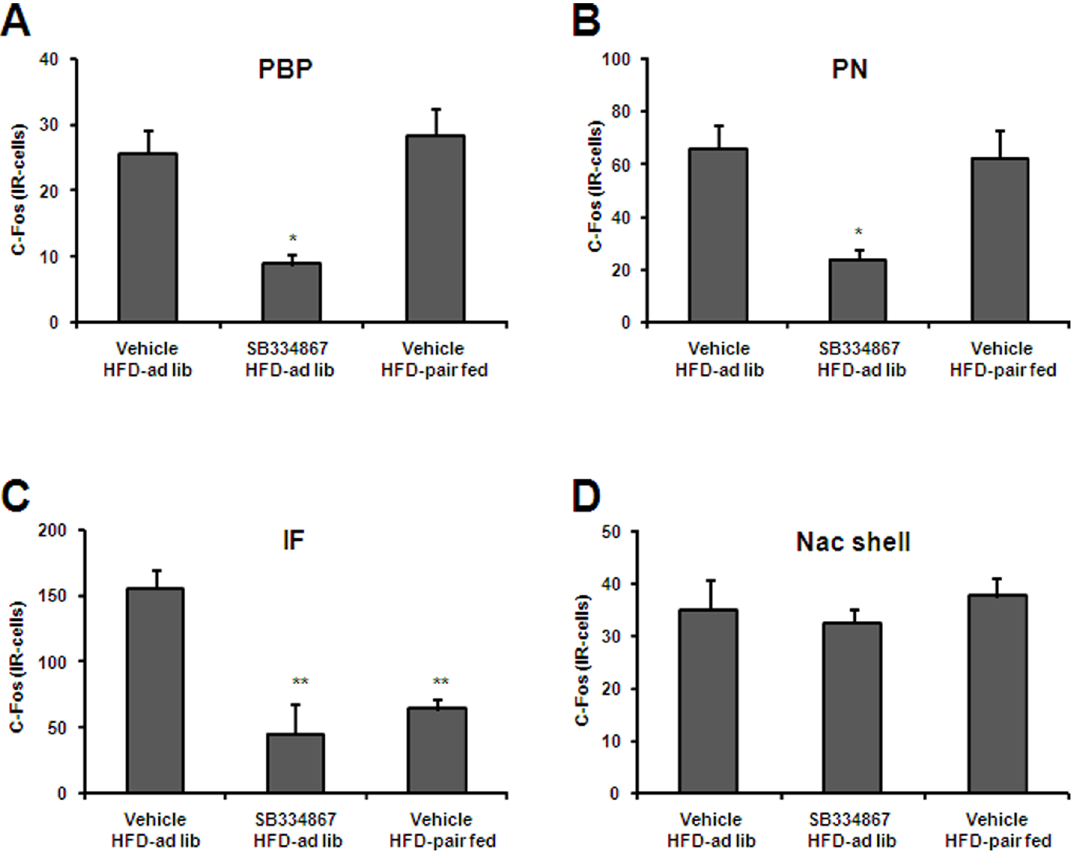
Figure 7. Orexin signaling blockade reduces HFD-induced increase of c-Fos in the VTA and not in the NAc. Panels A-D show quantitative analysis of c-Fos staining in specific PBP (A), PN (B) and IF (C) sub-regions of the VTA, and in the NAc shell (D) of vehicle-HFD- ad lib , SB334867-HFD- ad lib and vehicle-HFD-pair-fed groups. Histograms depict the total number of c-Fos-IR neurons, expressed as cells per coronal section. Values are the mean 6 SEM. *, p , 0.05 vs. vehicle HDF- ad lib group. **, p , 0.01 vs. vehicle HDF- ad lib group.